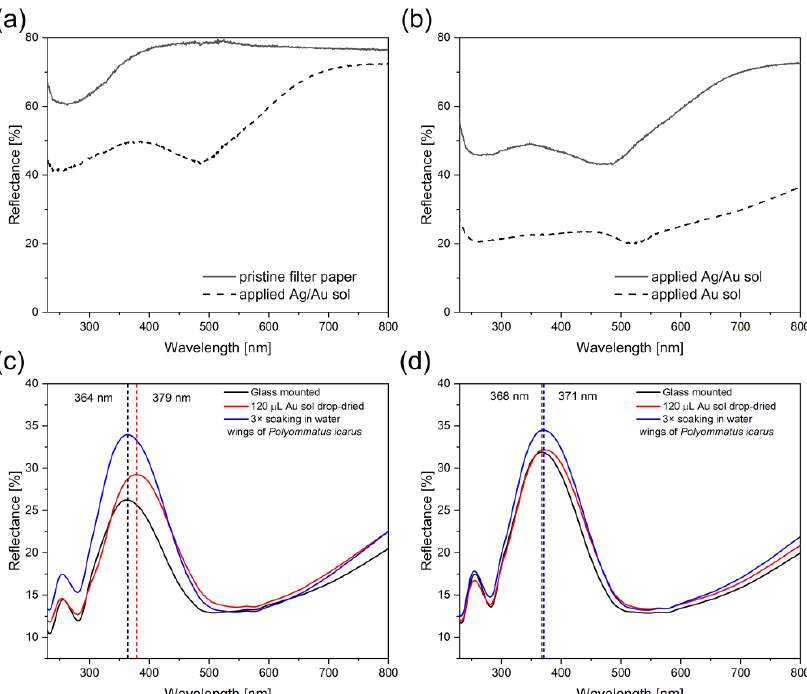
Figure 7. Reflectance measured with the integrating sphere of Au and Ag/Au NPs loaded filter papers and on blue butterfly wings of male Polyommatus icarus butterflies. ( a ) Pristine filter paper and Ag/Au NPs applied on the filter paper; ( b ) comparison of the reflectance of Au and Ag/Au NPs on the same type of filter paper; ( c ) butterfly wing mounted on glass substrate using PLA (black curve), after water soaking and drying followed by the application of 120 µL of Au NP sol and drying (red curve), after three cycles of soaking in deionized water (blue curve); ( d ) butterfly wing mounted on glass substrate using PLA (black curve), after water soaking and drying followed the application of 120 µL of Ag/Au NP sol and drying (red curve), after three cycles of soaking in de- ionized water (blue curve).